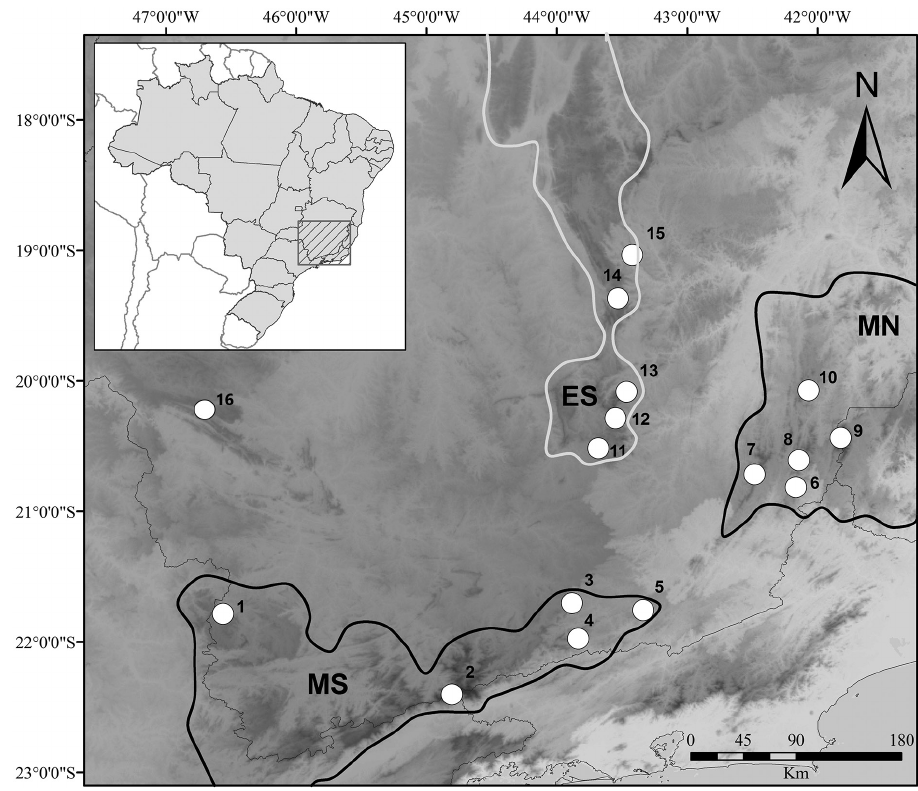
Figure 1 - Demarcation adopted for the Serra da Mantiqueira complex and Serra do Espinhaço and the localities used in this study: ( 1 ) Plateau of Poços de Caldas, ( 2 ) Serra do Itatiaia, ( 3 ) PE do Ibitipoca, ( 4 ) Serra Negra, ( 5 ) Municipality of Juiz de Fora, ( 6 ) Pedra Dourada, ( 7 ) Serra do Brigadeiro, ( 8 ) Municipality of Divino, ( 9 ) Serra do Caparaó, ( 10 ) Municipality of Simonésia, ( 11 ) Municipality of Ouro Branco, ( 12 ) Floresta Estadual do Uaimií, Municipality of Ouro Preto, ( 13 ) Serra do Caraça, ( 14 ) Serra do Cipó, ( 15 ) Microregion of Conceição do Mato Dentro and ( 16 ) Serra da Canastra. MS: South of Serra da Mantiqueira; MN: North of Serra da Mantiqueira; ES: South of Serra do